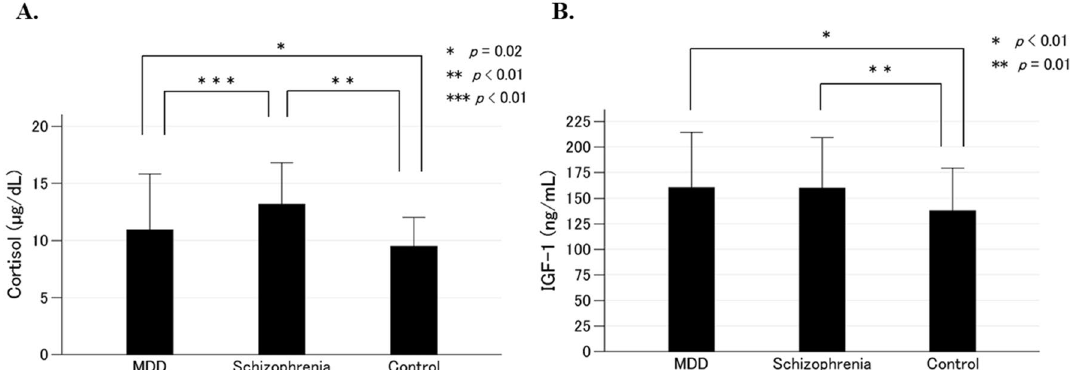
Figure 1. Serum levels of cortisol ( A ) and insulin-like growth factor 1 (IGF-1) ( B ) in patients with major depressive disorder (MDD), patients with schizophrenia, and controls. The mean and standard deviation for each group are shown as bar graphs and error bars, respectively. Serum cortisol levels in patients with MDD were higher than in controls ( p = 0.02), and those in patients with schizophrenia were higher than in controls and patients with MDD ( p < 0.01 and p < 0.01, respectively) ( A ). Serum IGF-1 levels were higher in patients with MDD and schizophrenia than in controls ( p < 0.01 and p < 0.01, respectively). There were no